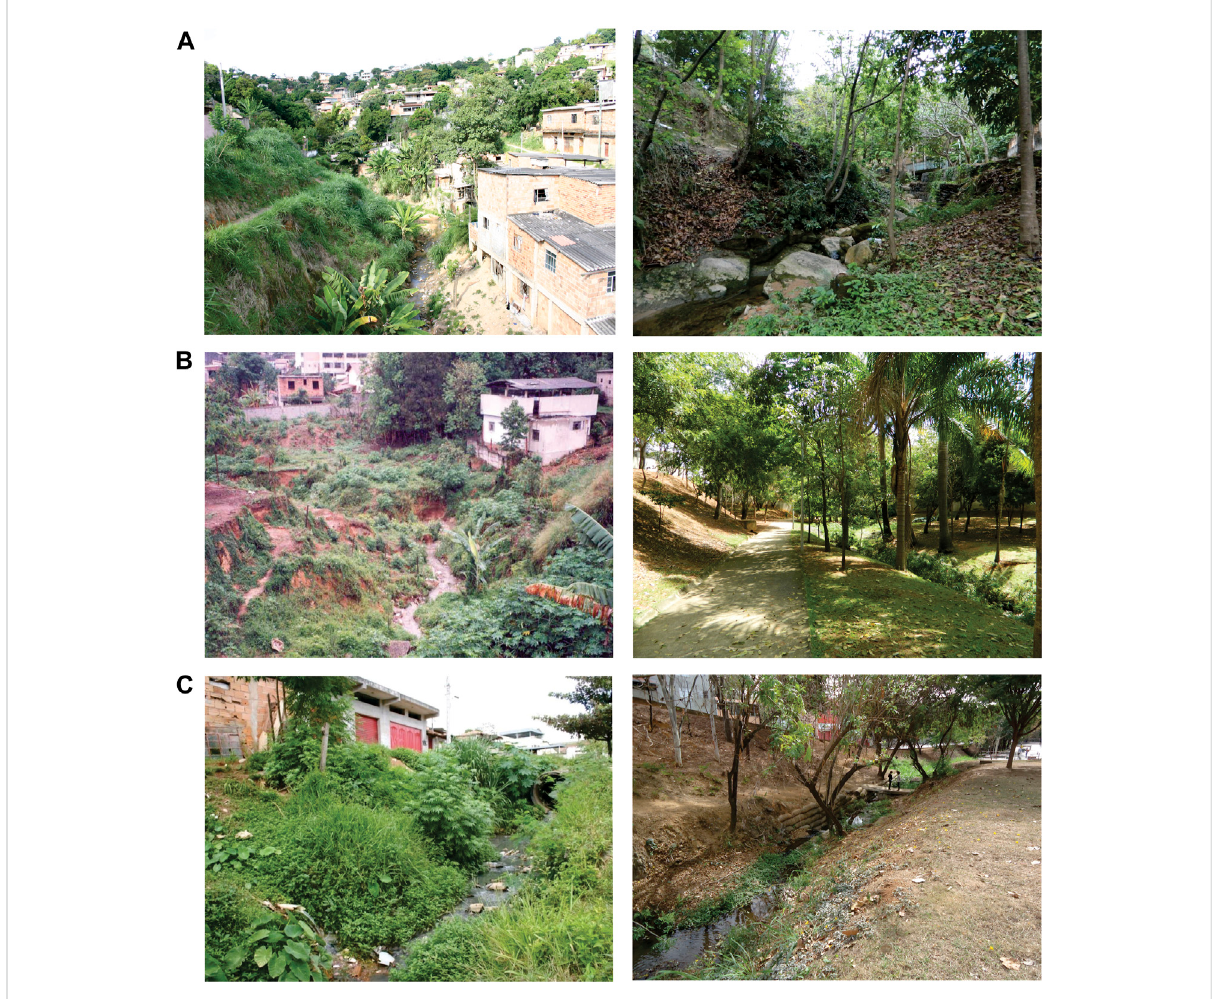
FIGURE 2 Partial views of sites before rehabilitation (left) in 2003 (photos by UEP/DRENURBS/Prefeitura de Belo Horizonte) and after rehabilitation (right) in 2019 (photos by D.R. Macedo). (A) Baleares; (B) Primeiro de Maio; (C) Nossa Senhora da